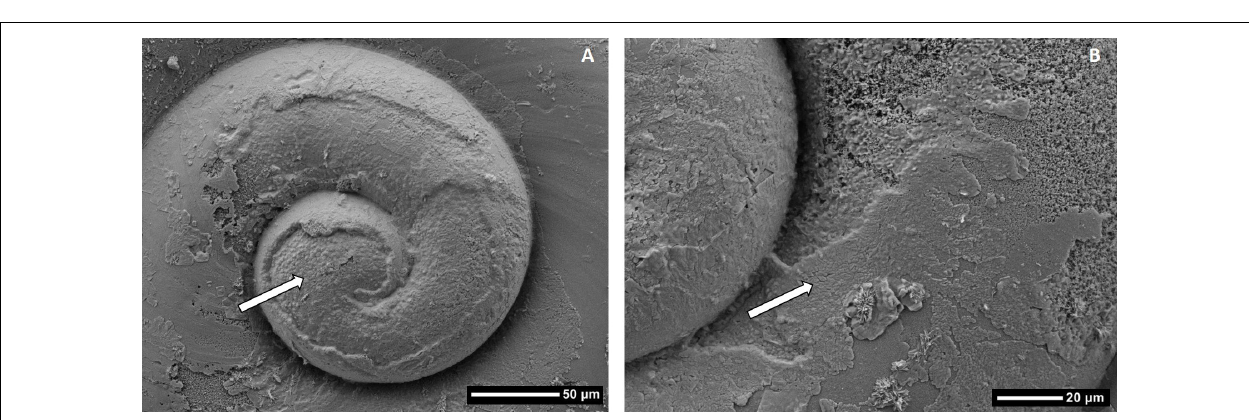
FIGURE 9 | Shell modification on adult Limacina helicina collected from Minto Inlet in 2014, (A) observed on recessed area of shell with severe underlying dissolution of the surface shell layer, (B) the modification on the shell is of crystalline origin, yet it appears unstructured relative to typical pteropod shell microstructure. The white arrow points to the recessed area (A) and shell modification layer (B)